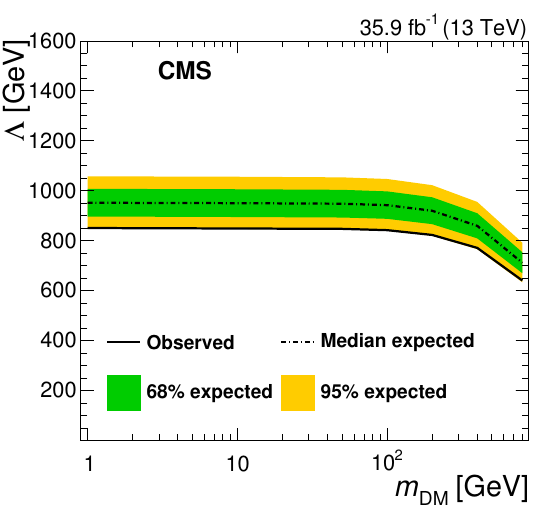
Figure 9 . The 95% CL observed and expected lower limits on (cid:3) for an e(cid:11)ective EWK-DM contact interaction, as a function of dark matter mass m DM .